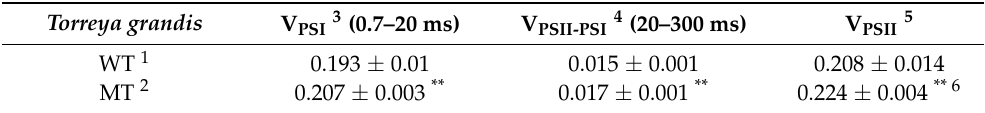
Table 2. Parameters derived from the modulated 820 nm reflection (MR/MRo) of the mutant-type and wild-type Torreya grandis